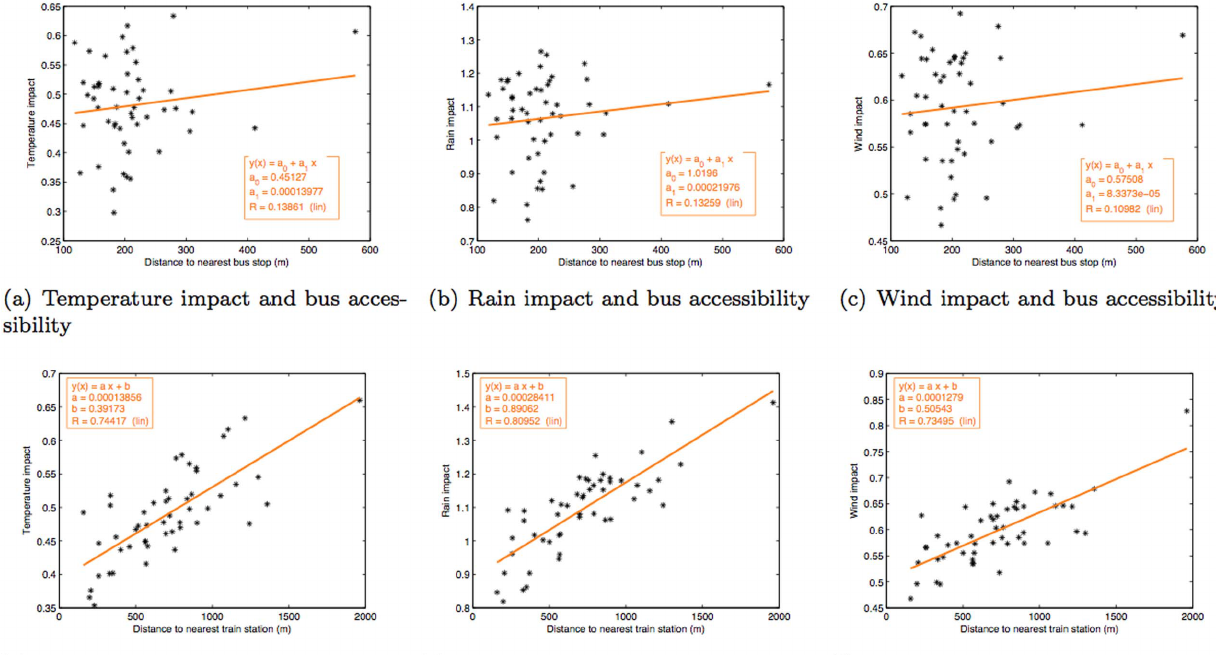
Figure 18. Relationship between the weather impact and accessibility of pubic transportation.